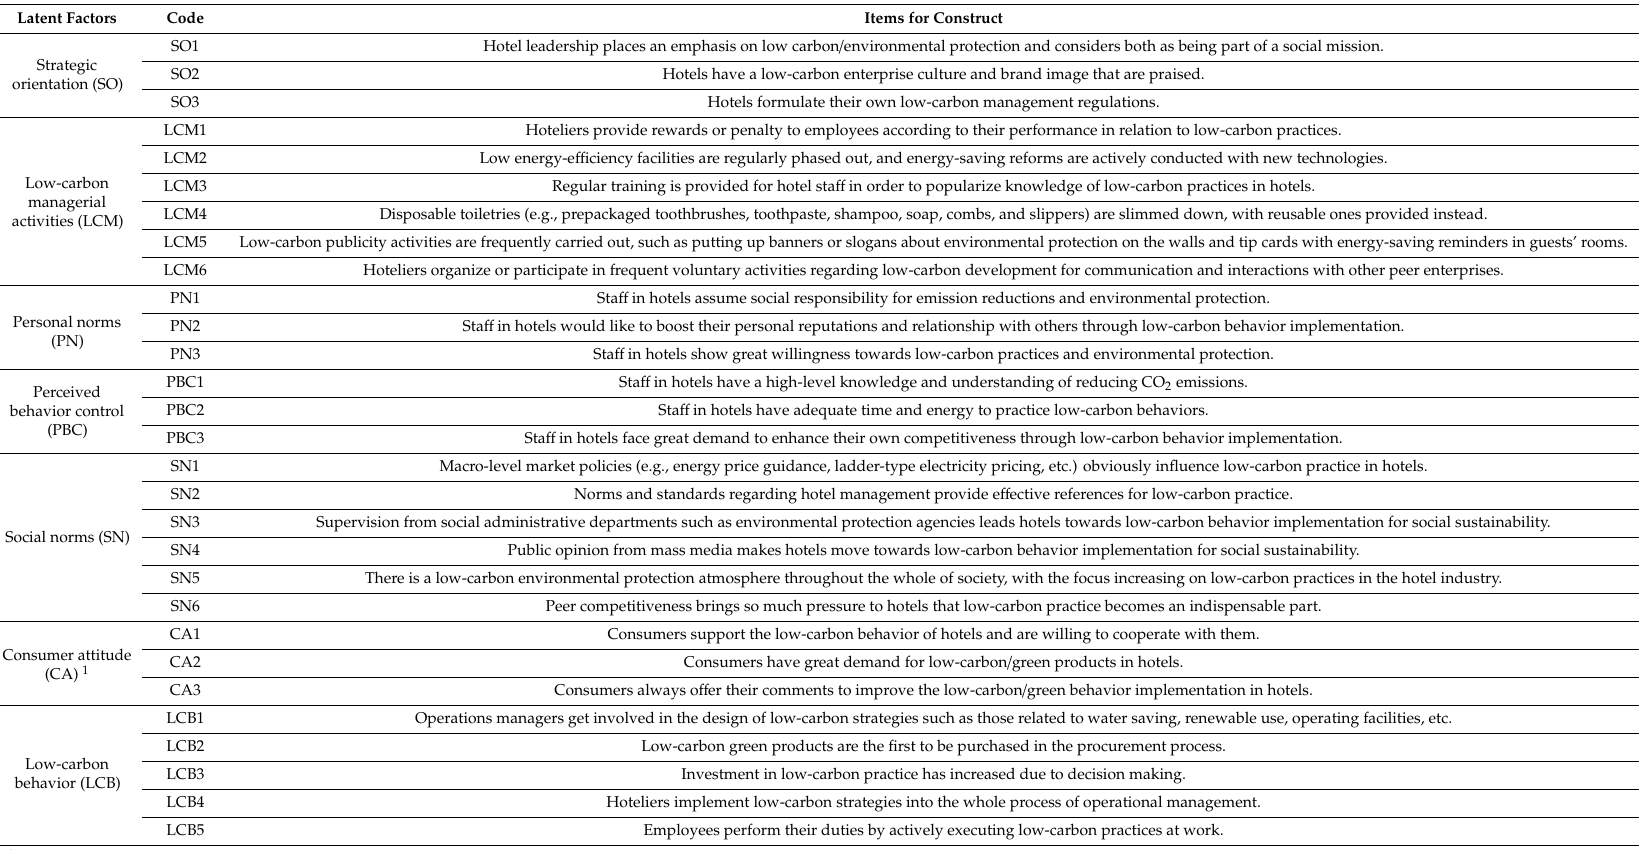
Table 3. Factors and measurement items for low-carbon sta ff behavior adoption in star-rated